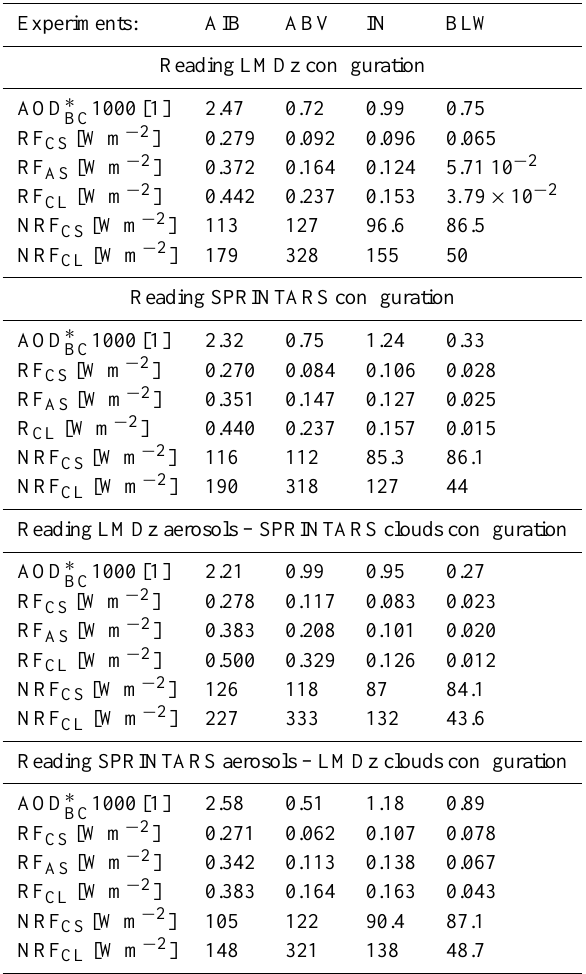
Table 4. Black carbon optical depth (AOD BC ) and associated forc- ings for four experiments (as detailed in Table 3) and four configura- tions in which monthly LMDz and SPRINTARS aerosol and cloud fields are read. Abbreviations as in Table